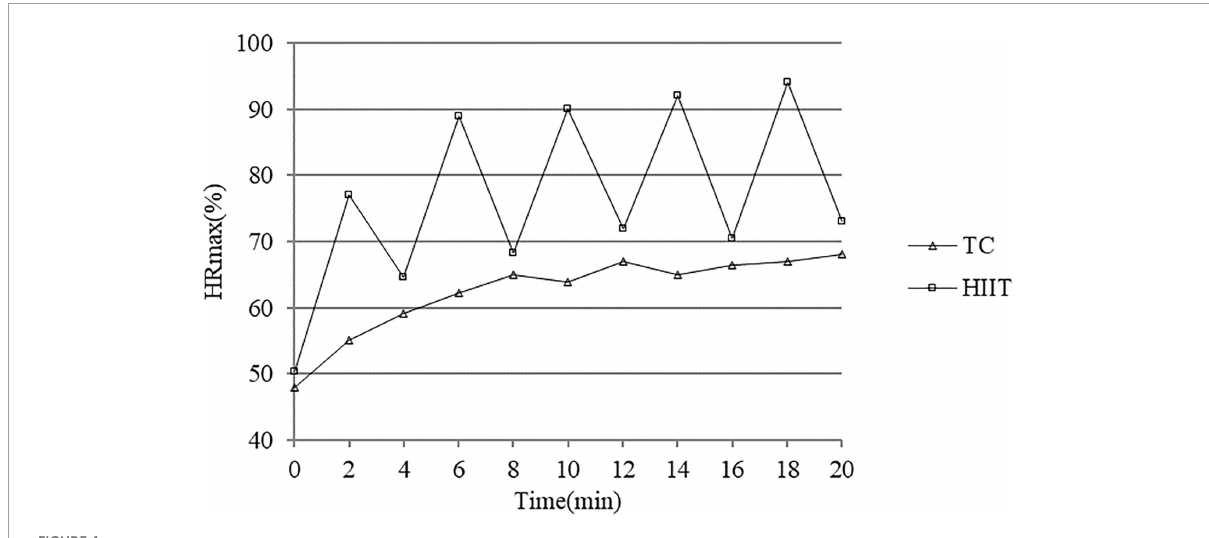
FIGURE4 HR max observed during each exercise